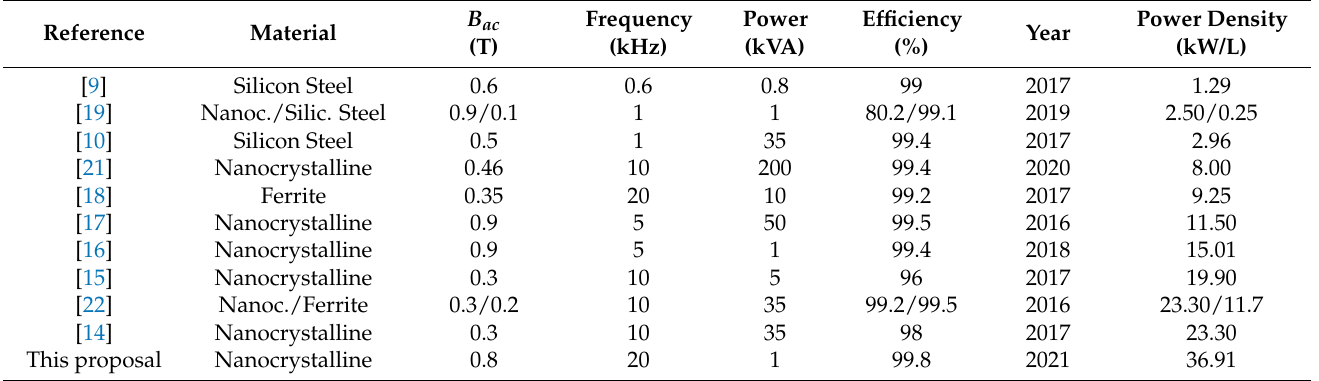
Table 13. MFTs with high power density within the mid-frequency range (600–20